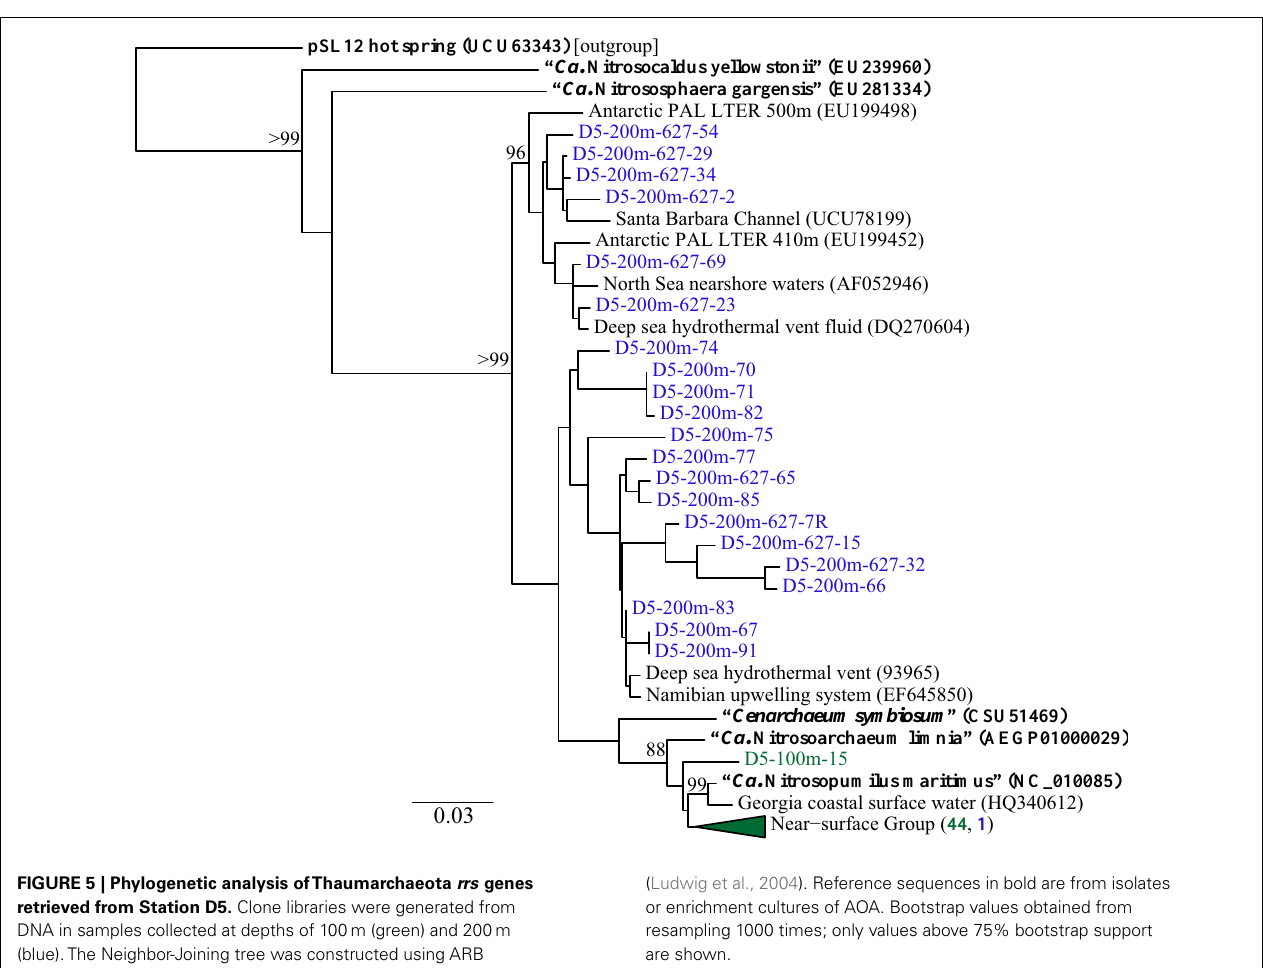
(Ludwig et al., 2004). Reference sequences in bold are from isolates or enrichment cultures of AOA. Bootstrap values obtained from resampling 1000 times; only values above 75% bootstrap support are